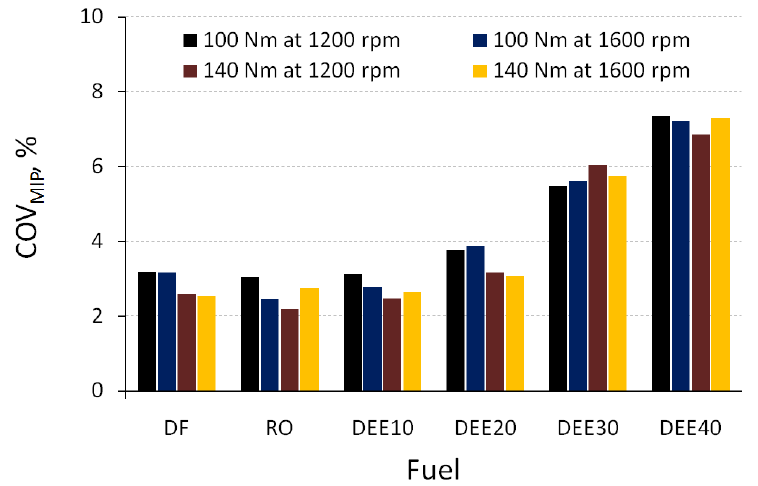
Figure 8. Impact of tested fuels on COV MIP calculated for the AD3.152 engine.